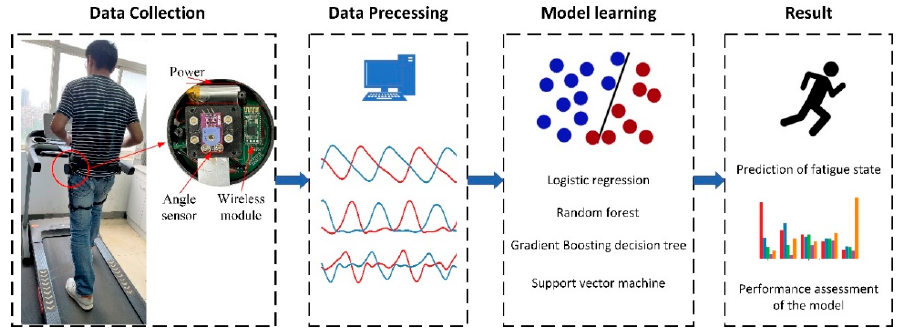
Figure 1. System flowchart of hip gait data activity analysis. The wearable device collects hip angle data. The data are preprocessed and used for model learning. A performance assessment of various classification models in identifying fatigue states is given.